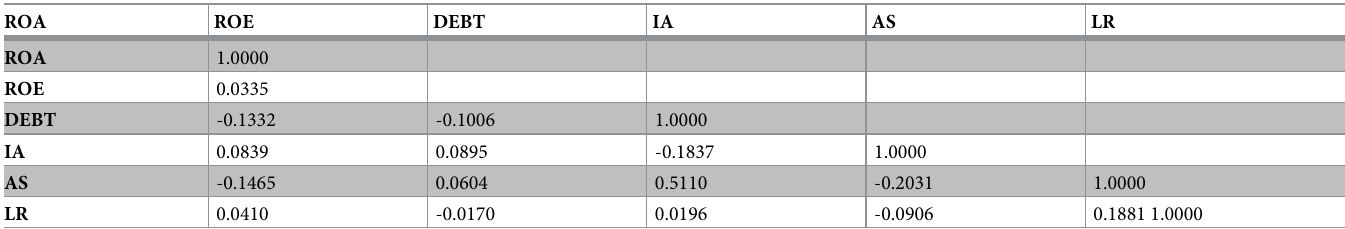
Table 3. Correlation matrixes.